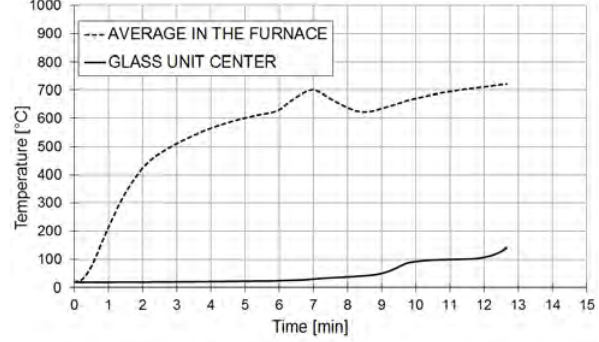
Figure 11: The comparison of the temperature inside the furnace and in the center of the glass